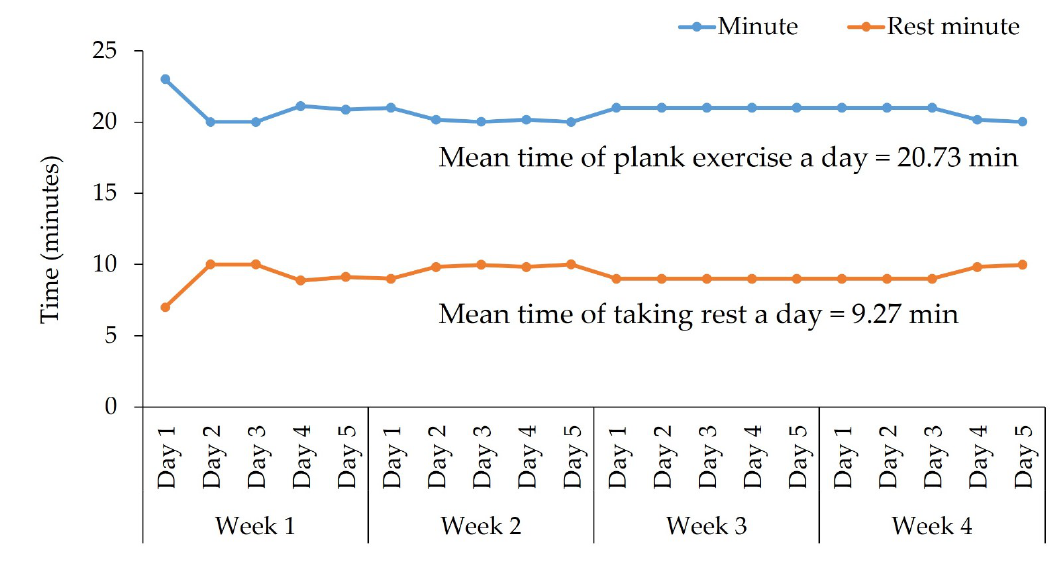
Fig. 3. Total time of elbow plank exercise for 4 weeks.